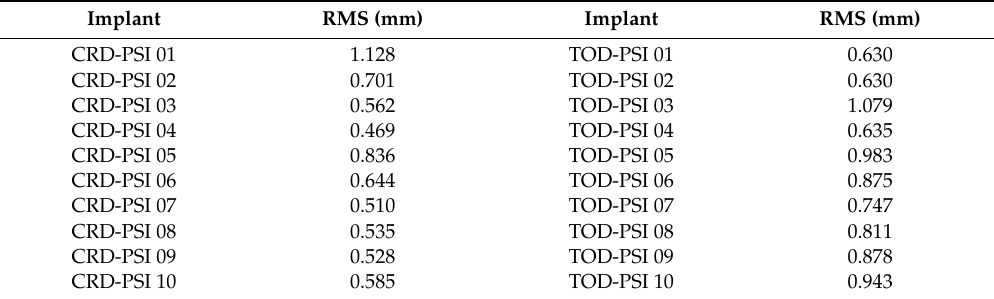
Table 3. Quantitative evaluation of the CRD-PSIs and TOD-PSIs accuracy with respect to the root mean square (RMS) values (mm).